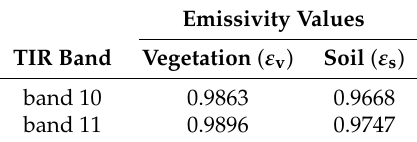
Table 5. Emissivity values of soil and vegetation for TIR band 10 and band 11. Source: Reference